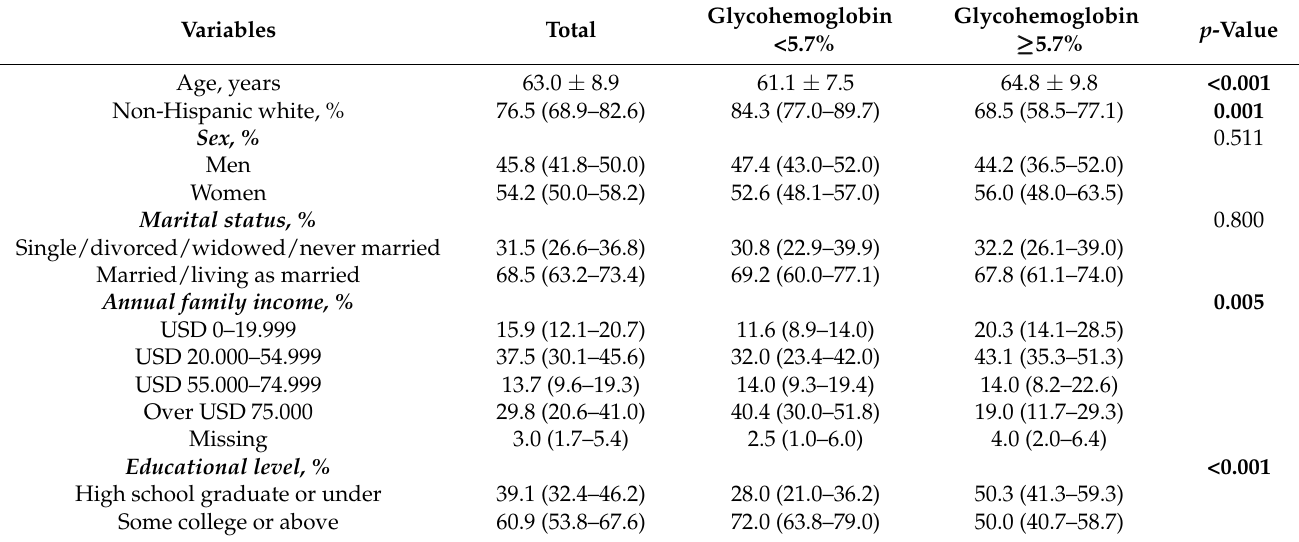
Table 1. Sociodemographic, anthropometric and body composition characteristics in individuals with elevated and normal glycohemoglobin. NHANES,